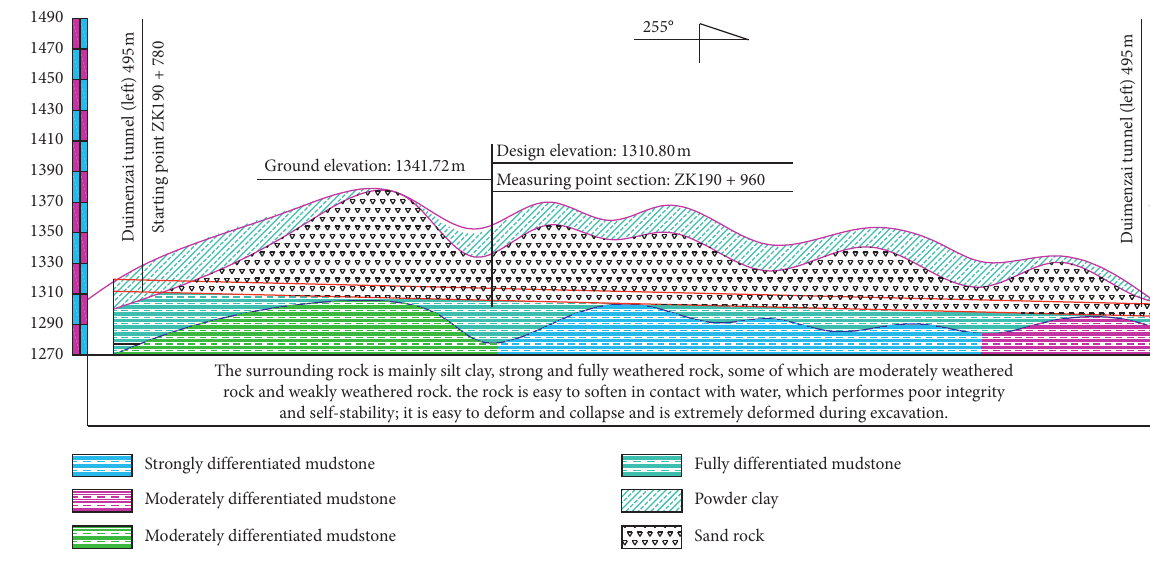
Figure 1: Schematic map of geological profile design (unit: m).